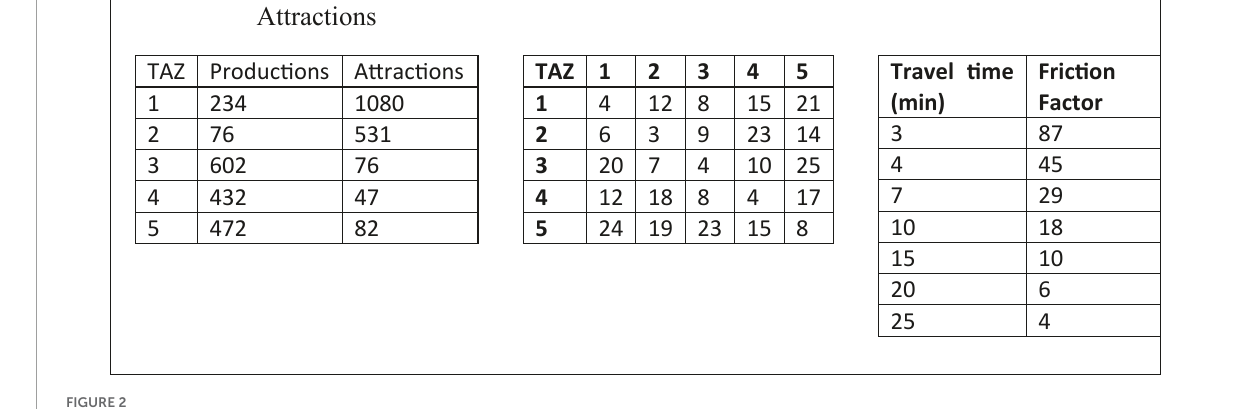
FIGURE2 Sample in-class activity from the transportation planning course.